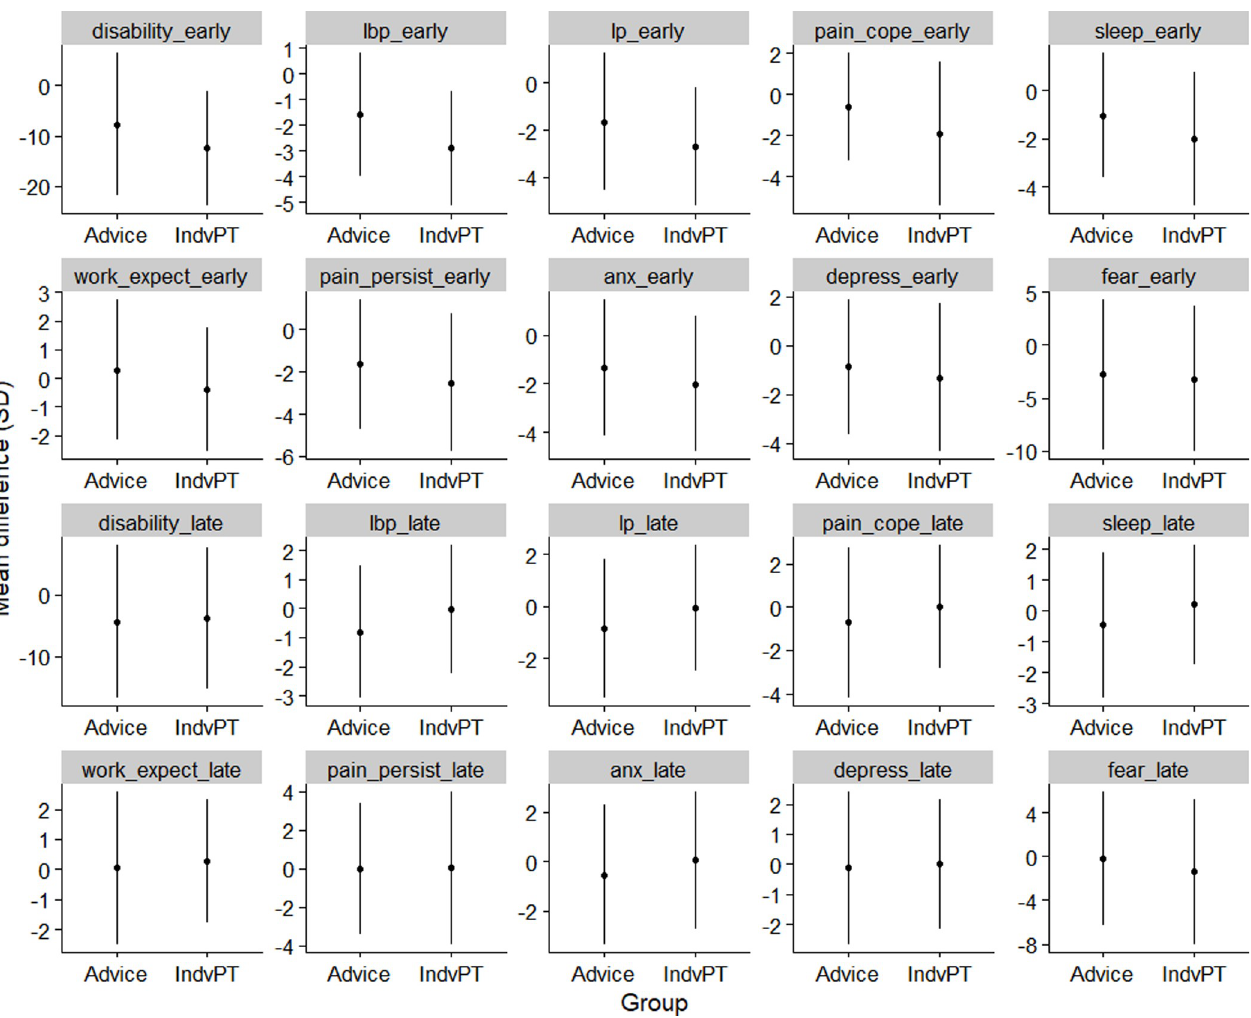
Fig 1. Mean with error bars (one standard deviation) of the change values of each modelled variable in the Bayesian Network. Abbreviation: Suffix with “_early”–change score between baseline and week-10 follow-up; “_late”–change value between week-10 and week-52; Anx—anxiety; lbp–low back pain; lp–leg pain; IndvPT–individualised